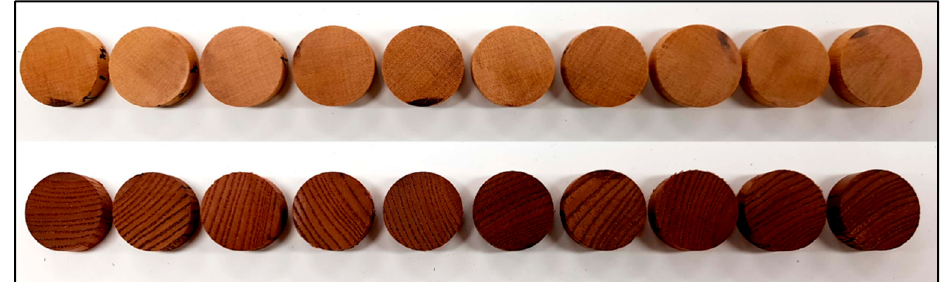
Figure 1. Sample preparation of momala ( up ) and red toon ( down ).